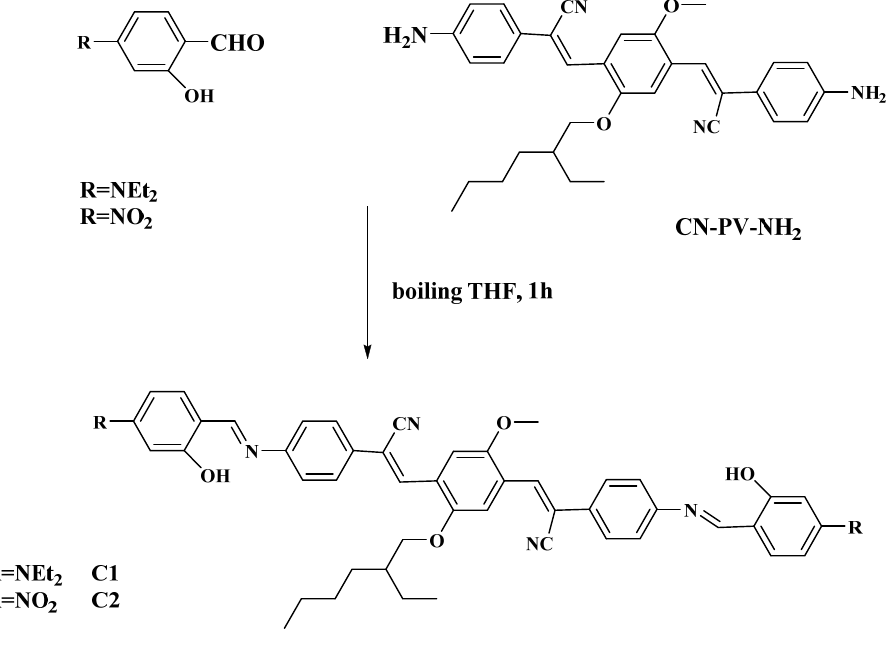
Scheme 1. Structure of fluorophores C1 and C2. Table 1. Optical data for C1 and C2 recorded in solution and as crystalline neat